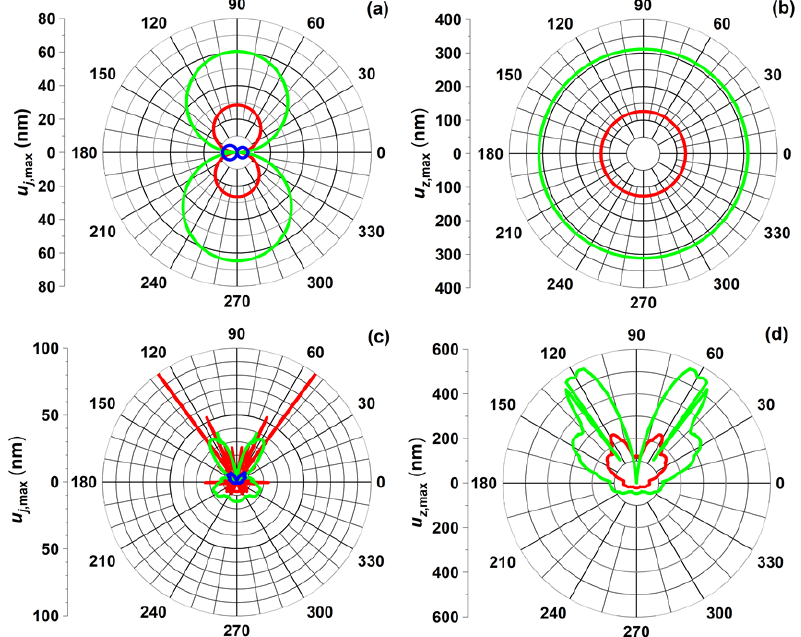
Figure 5. Angular dependences of the maximum displacements at the (0.5 m, 45 ◦ , 1 m) position: radial (red line), axial (green line), and tangential (blue line) displacements generated by ( a , c ) P j and ( b , d ) P z of 1.0 N, located at ( a , b ) (0 m, 0 m, 1 m) and ( c , d ) (0 m, 0.25 m, 1 m) positions.